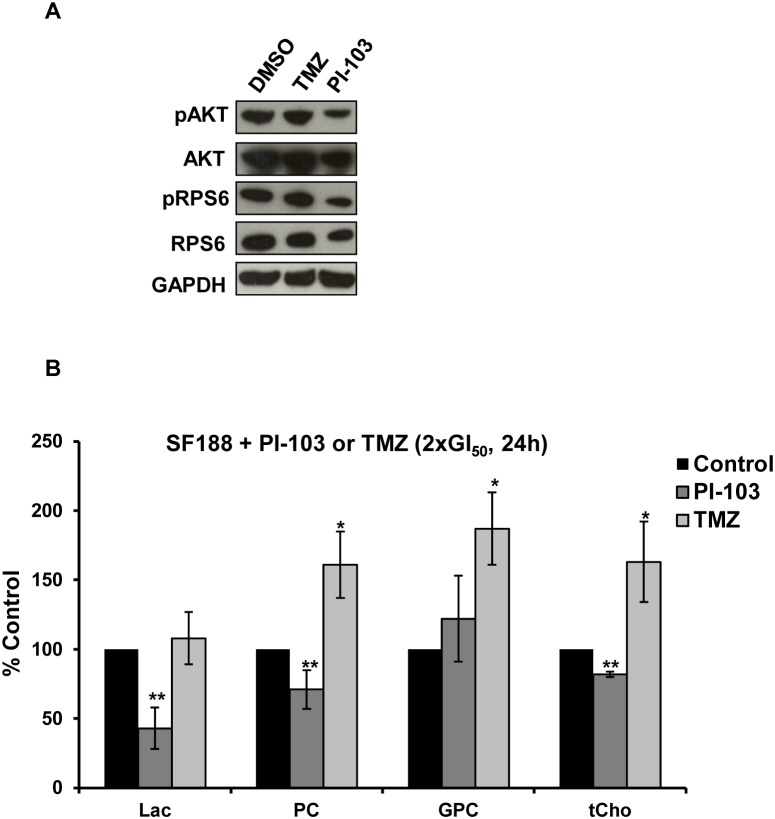
Comparison of molecular and metabolic changes caused by 24 hours treatment of SF188 pediatric glioblastoma cells with PI-103 or TMZ at 2×GI50.(A) Representative Western blots showing inhibition of the PI3K signaling pathway as indicated by decreased phosphorylation of AKT (Ser473) and RPS6 (Ser240/244) following treatment with PI-103 but not with TMZ. (B) Quantification of 1H-NMR detected metabolite changes. Results are expressed as percentage of treated to control and presented as the mean ± SD (error bars) of at least three separate experiments. Statistically significantly different from the control *p≤0.05, **p≤0.01, ***p<0.005, ¥p<0.0005; two-tailed unpaired t test was used for all comparisons.